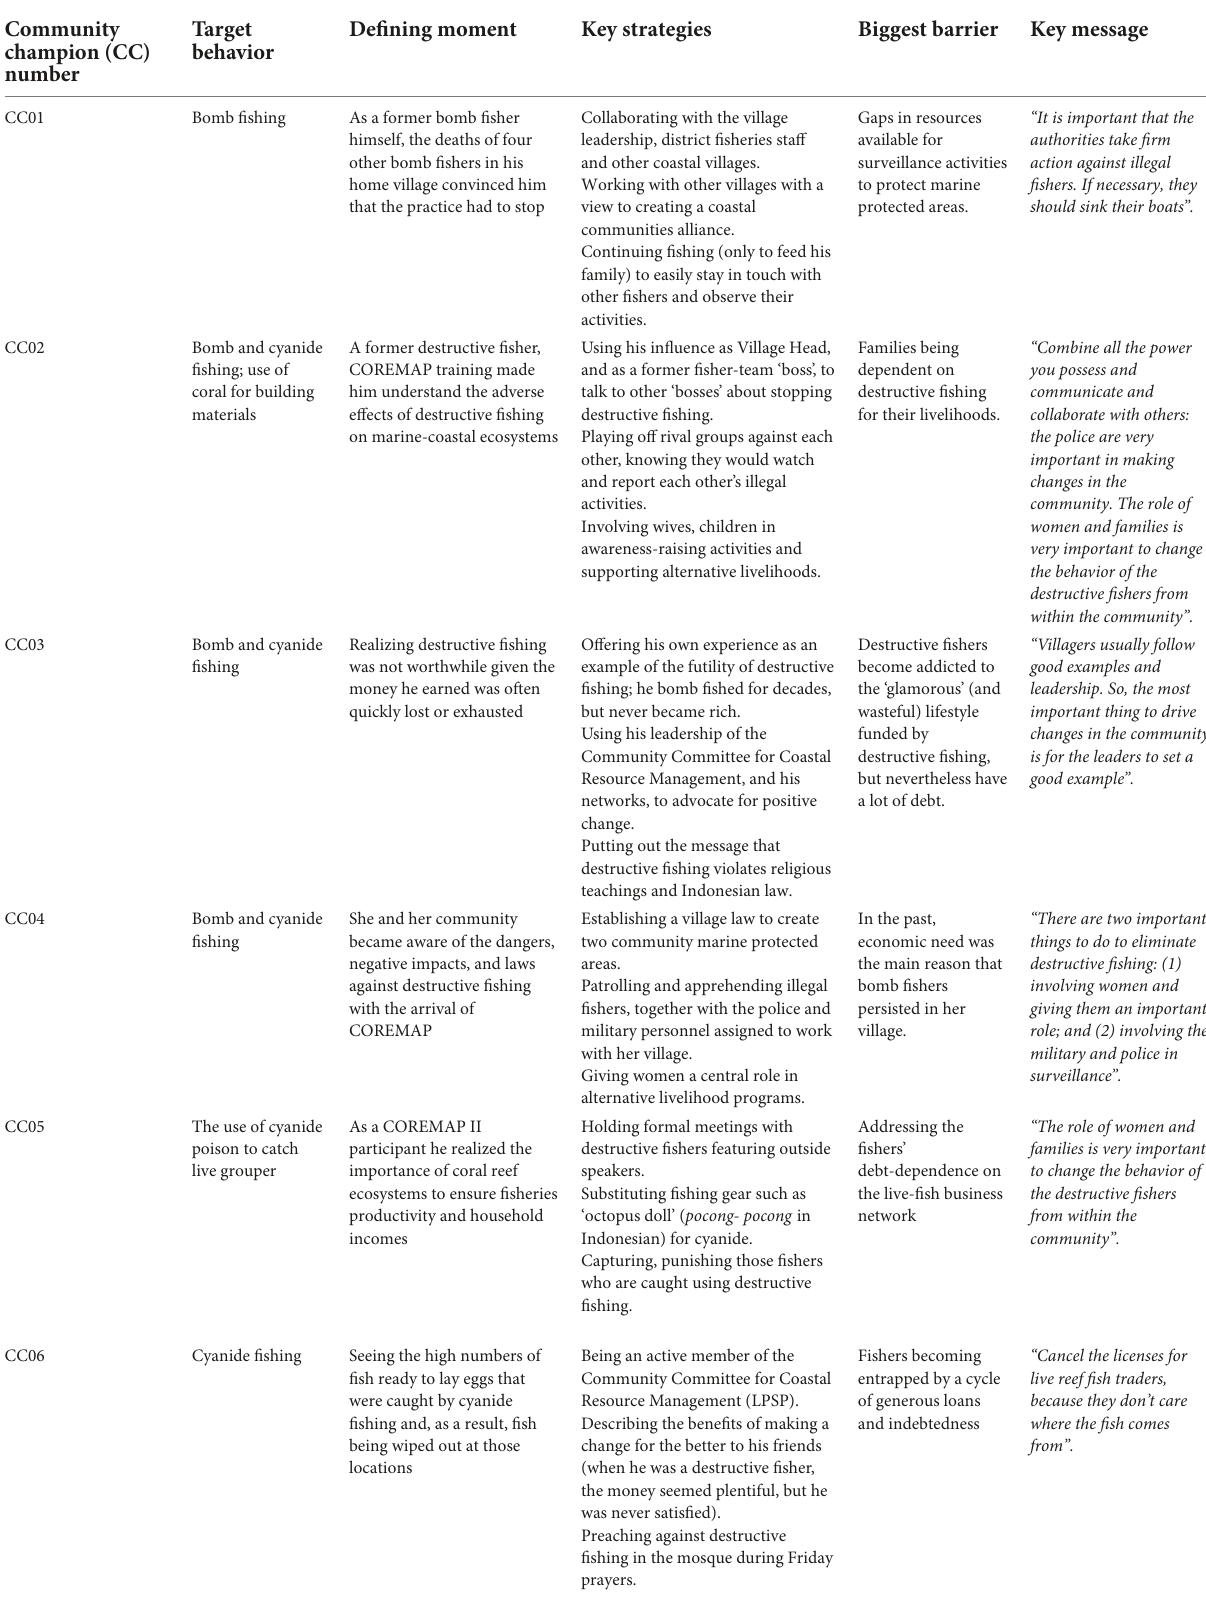
TABLE 1 Summary of community champions, their strategies, barriers and messages. Community champion